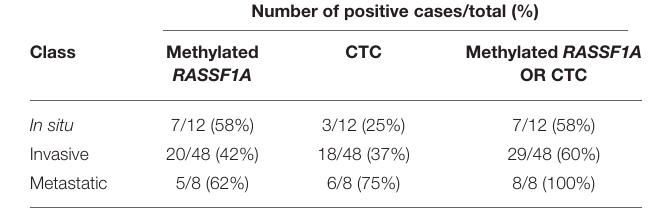
TABLE 4 | Distribution of positive and negative cases for RASSF1A methylation in cfDNA and for the presence of CTCs as assessed by ISET (Fisher’s exact test p = 0.790 ).